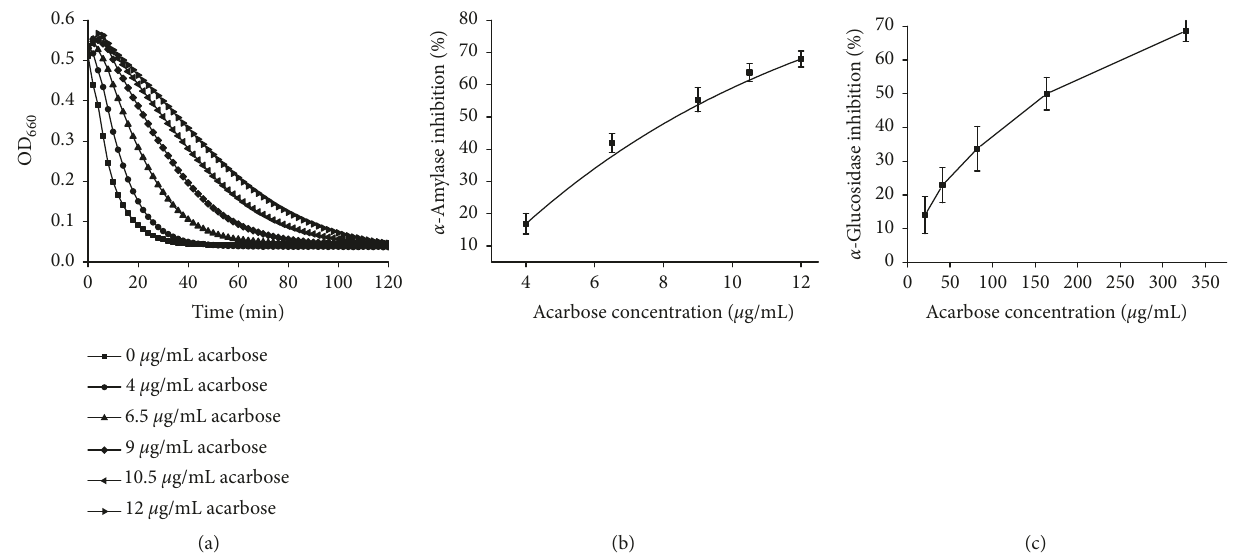
Figure 6: (a) Kinetic curves of starch hydrolysis by α -amylase in the presence of acarbose. Dose-response curves of acarbose for inhibitory activities against α -amylase (b) and α -glucosidase (c). Data are presented as mean